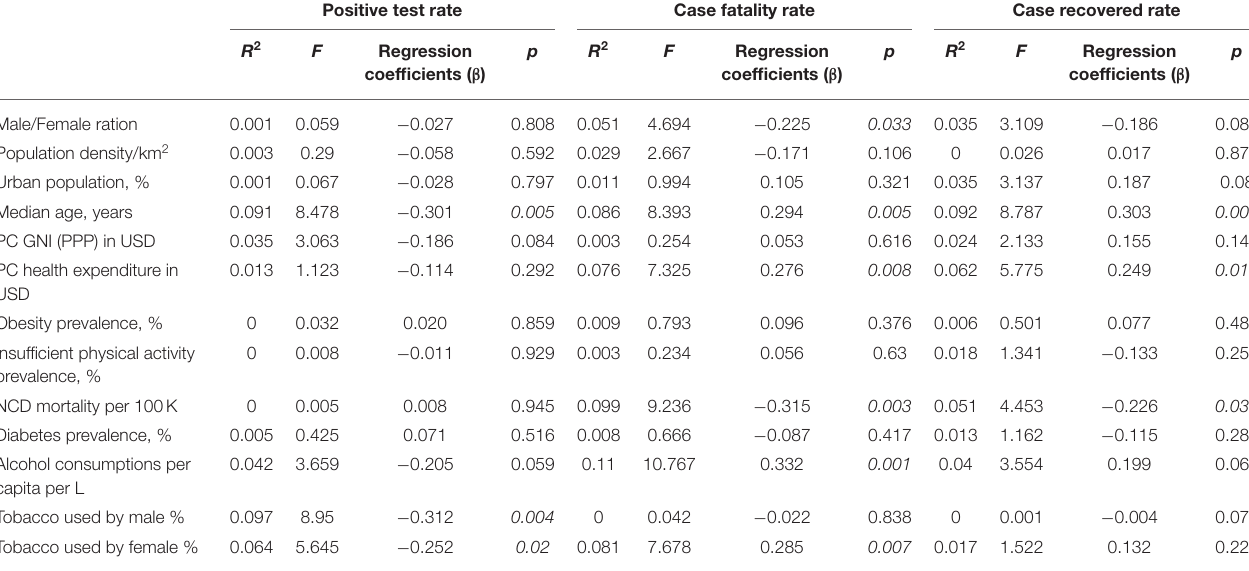
TABLE 2 | One to one linear regression analysis using ungrouped independent